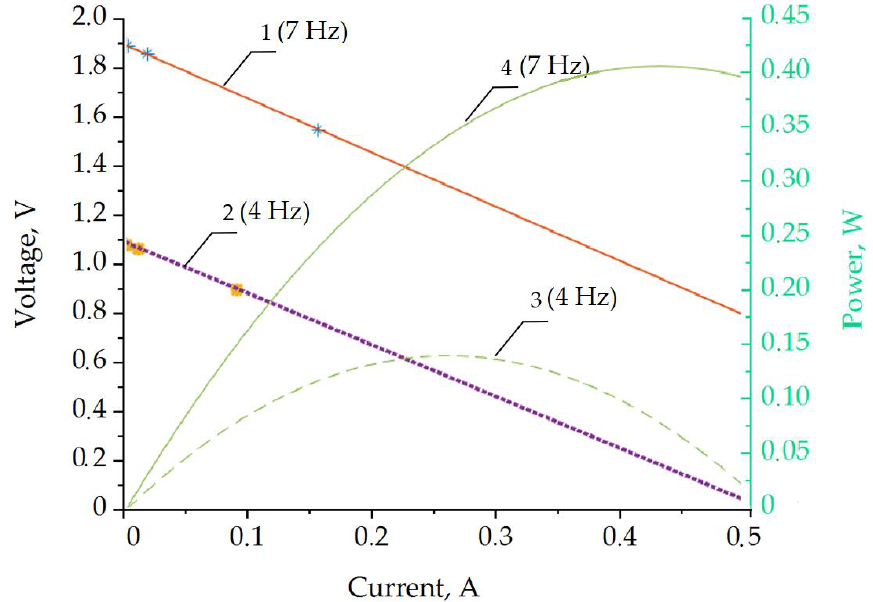
Figure 10. Output power characteristics of the prototype single-coil energy harvester. Load characteristics correspond to left axis: line 2 – 4 Hz; line 1 – 7 Hz. The electrical power output refers to the right (power) vertical axis: line 3 – 4 Hz; line 4 – 7 Hz.